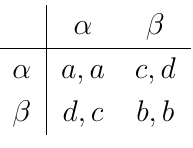
Table 1. A general two-person, two strategies coordination game.